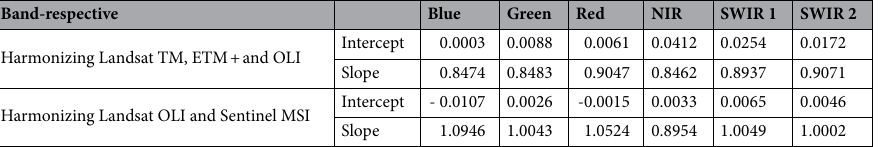
Table 3. Band-respective coefficients are defined with slope and intercept image constants and used for the harmonized Landsat OLI and Sentinel MSI images.